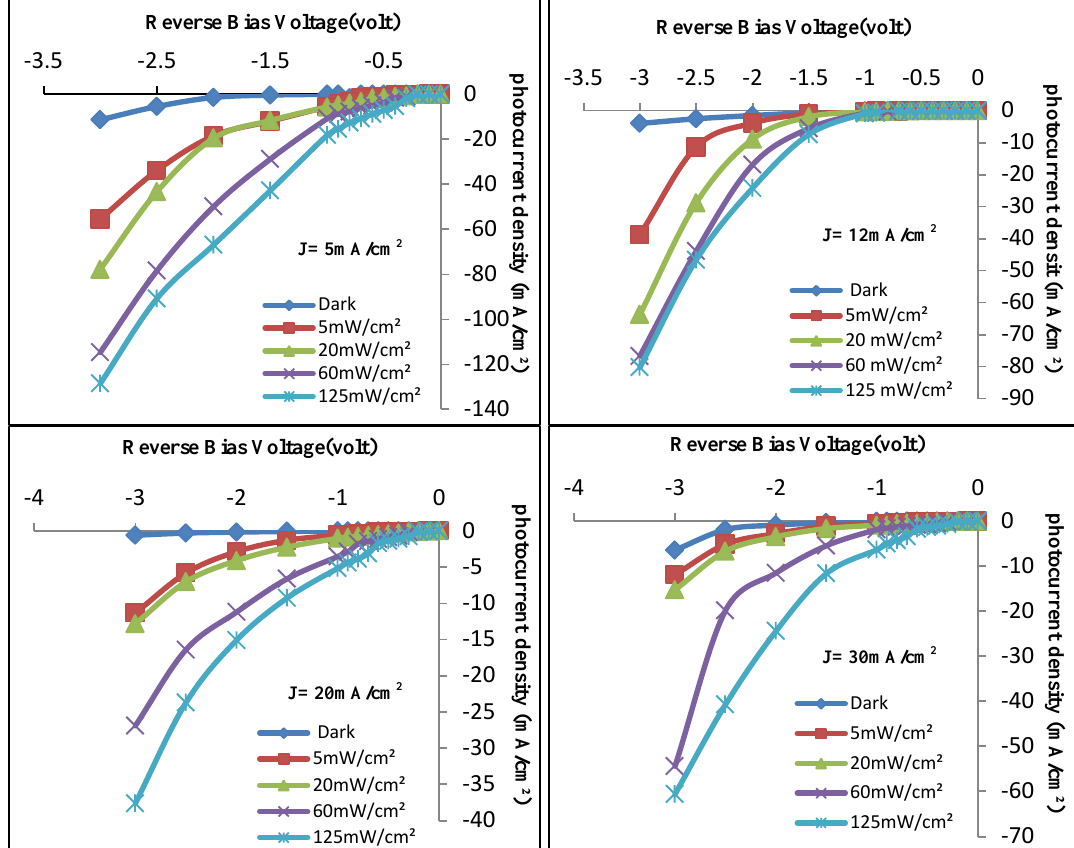
Fig. 8: Photocurrent density-Voltage characteristics of PS prepared with different etching current density J= 5, 12, 20 and 30 mA/cm 2 respectively, etching time was 15 min and the HF concentration was